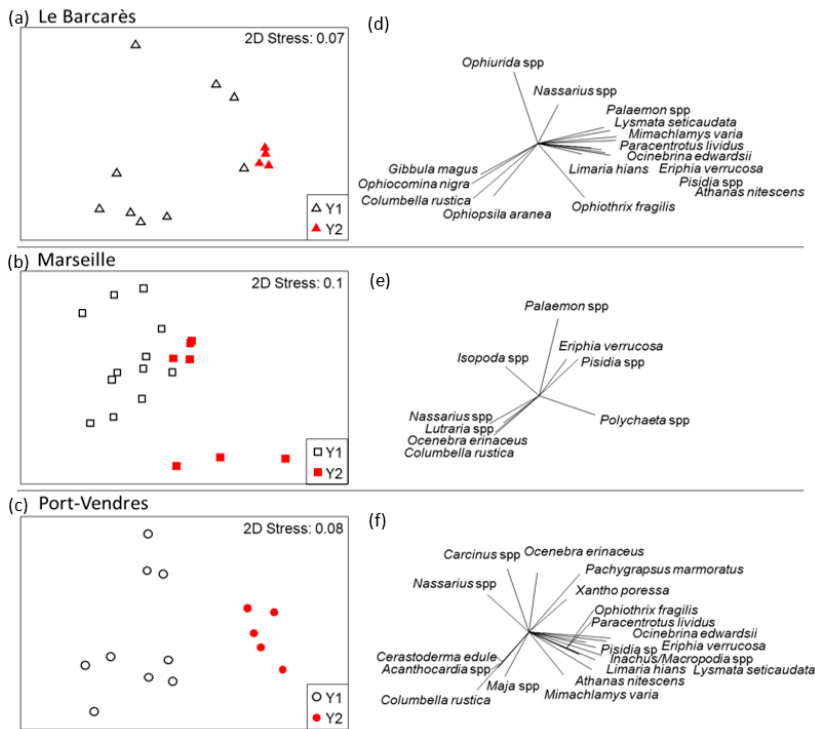
Figure 3. Non-metric multidimensional scaling analysis showing: Variation in taxonomic composition of invertebrate assemblages among surveyed Dock Biohut structures in each harbour between years (Y1 and Y2) since installation (( a – c ); log x + 1 transformed data); and the relative contribution of species to variation at each harbour (( d – f ); >0.5 Pearson correlation).